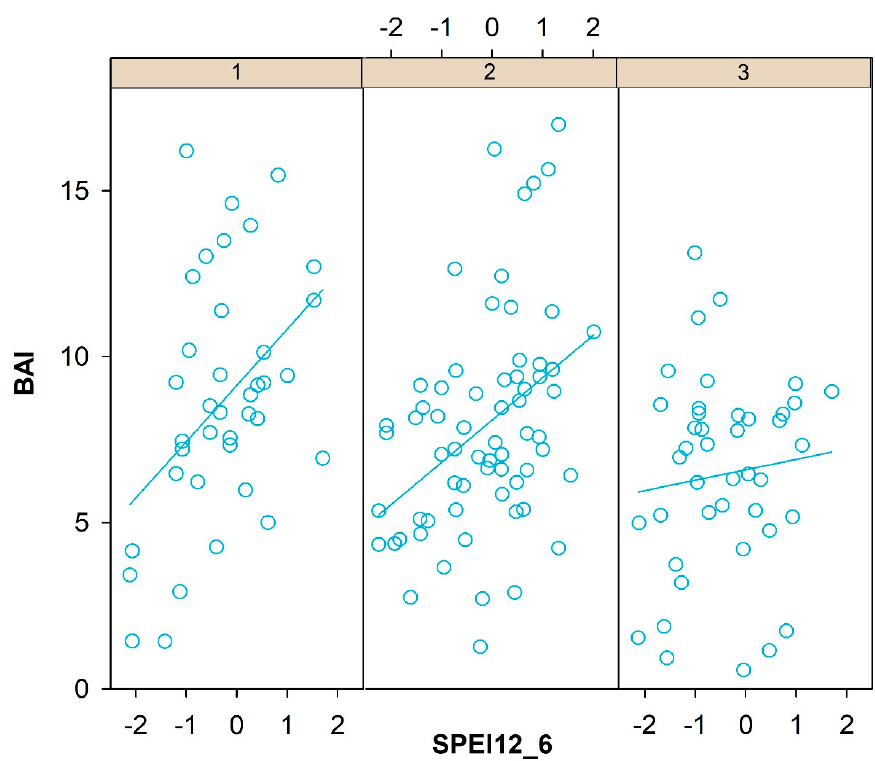
Figure 7. Effects of SPEI12_6 on the BAI, based on a linear mixed-effects models fitted to basal area increment data for the period 2000–2017 according to defoliation level (1—no defoliation, 0%–5%; 2—moderate defoliation, 5%–20%; 3—severe defoliation, >20%). The relationships described by the fitted lines are significant ( p <